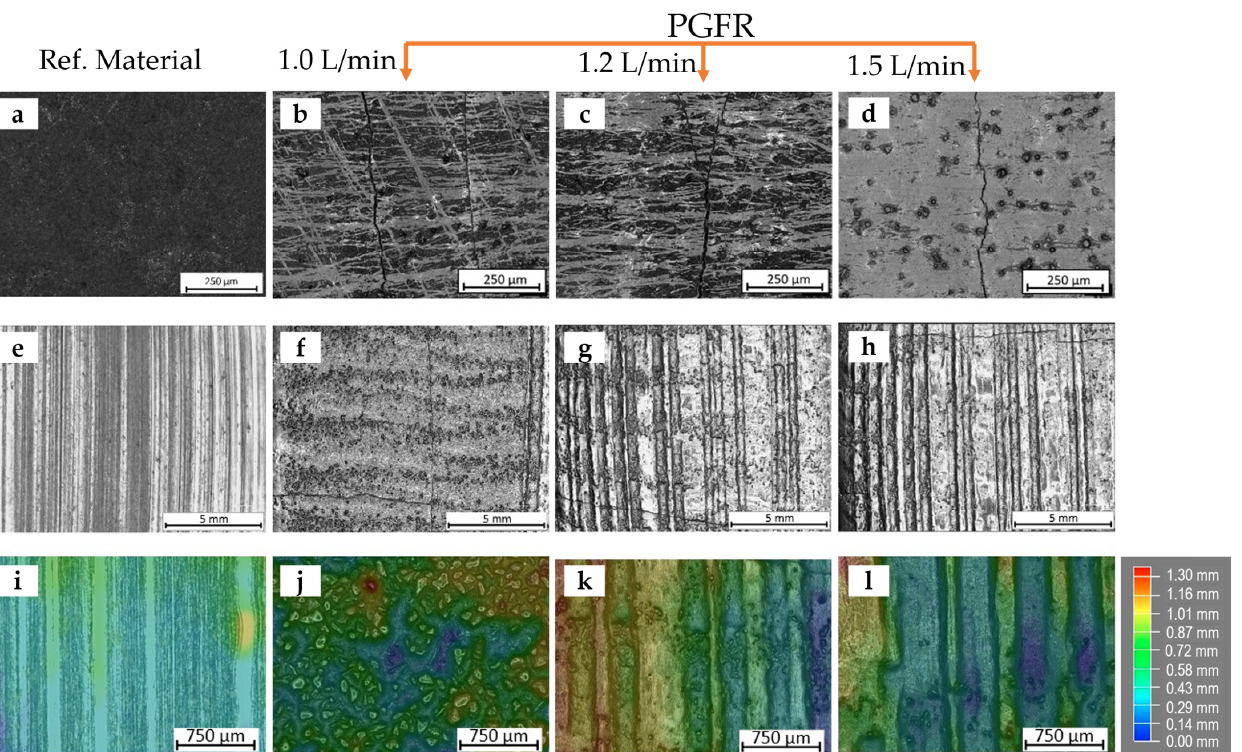
Figure 16. Images of the surfaces of specimens before and after abrasive wear test ( a , e , i ), reference material AR400 steel before abrasive wear test, after abrasive wear test and wear depth after abrasive wear, respectively ( b , f , j ) specimen 1-PE with PGFR of 1.0 L/min and PTA current of 110 A before abrasive wear test, after abrasive wear test and wear depth after abrasive wear, respectively ( c , g , k ) specimen 2-PE with PGFR of 1.2 L/min and PTA current of 110 A before abrasive wear test, after abrasive wear test and wear depth after abrasive wear, respectively ( d , h , l ) specimen 4-PE with PGFR of 1.5 L/min and PTA current of 110 A before abrasive wear test, after abrasive wear test and wear depth after abrasive wear, respectively.